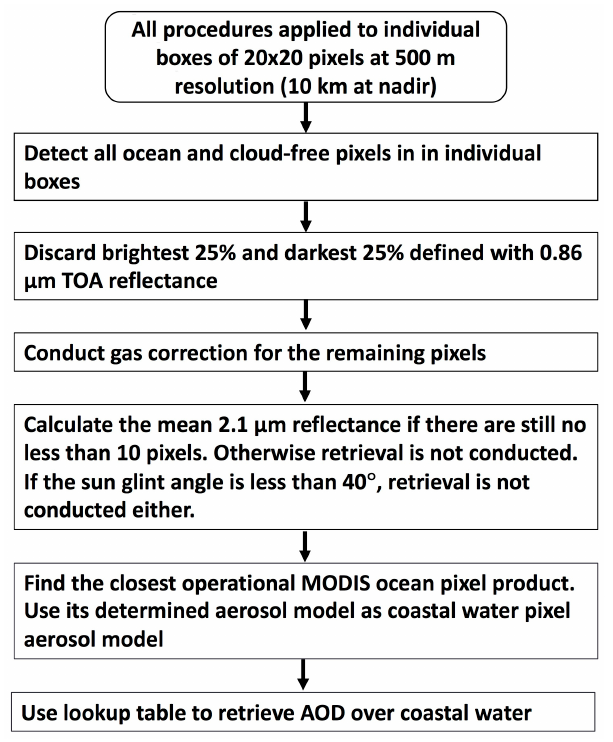
Figure 3. Flowchart of retrieving AOD over coastal water.